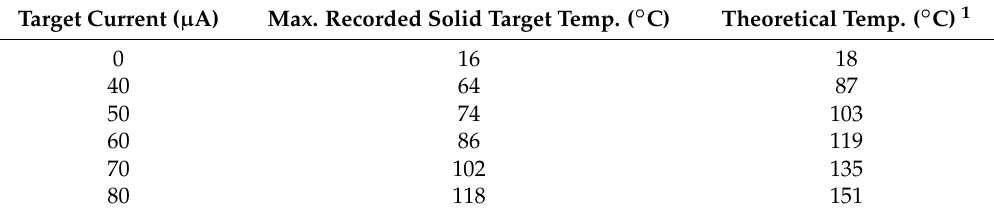
Table 3. Maximum recorded temperature for 64 Ni on Au using the new solid target system.